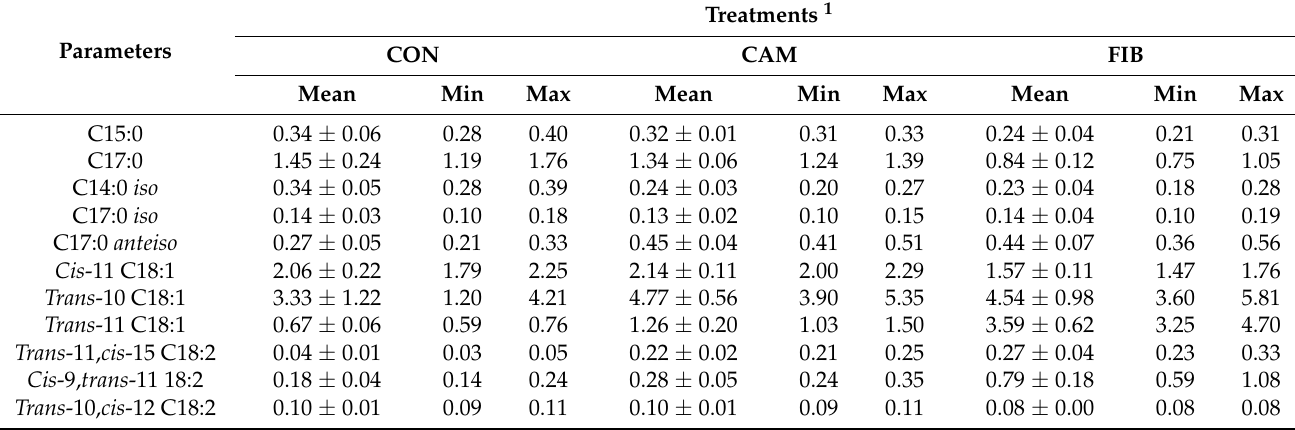
Table 2. Mean ( ± standard deviation), minimum (Min) and maximum (Max) contents of fatty acids quantified in the Longissimus thoracis muscle of lambs fed the experimental diets that were selected to be included in the study. Data expressed as g per 100 g of total fatty